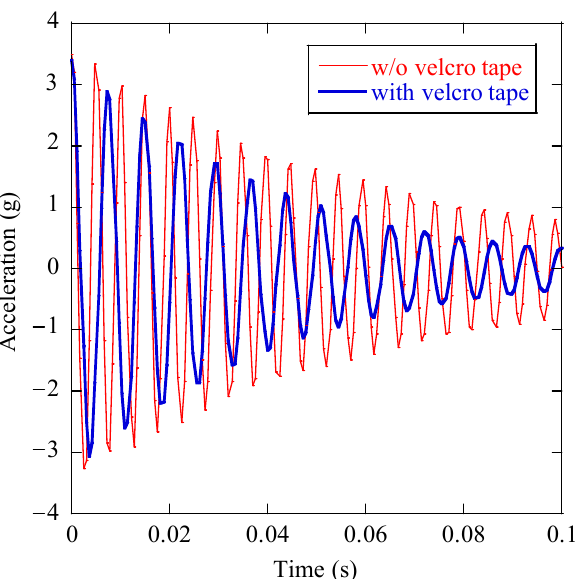
Figure 7. Free vibration test setup configuration of the solar panel employing the Velcro tape-type HRM.